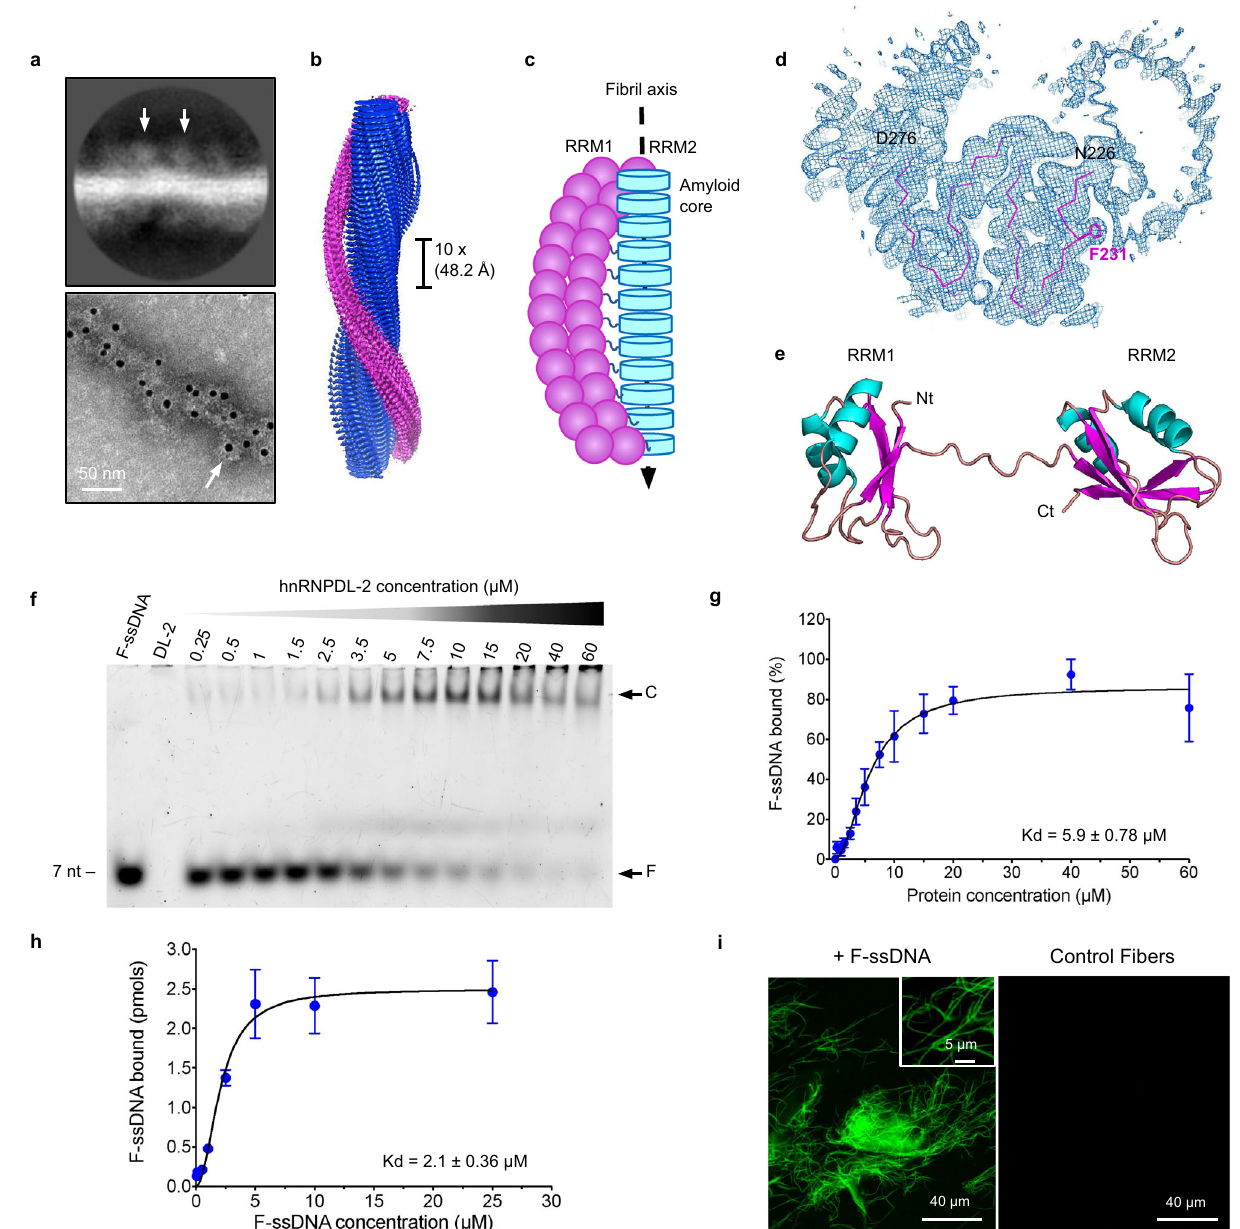
Fig. 4 | Structure oftheRNA/DNA-binding domains fromhnRNPDL-2and their location in the amyloid fi laments. a Top panel, representative 2D class average image showing hnRNPDL-2 fi brils with an approximate solenoid coat of globular domains. The arrows indicate the location of the density assigned to the RRMs. Bottompanel,negative-stainelectronmicroscopy(EM)micrographsofhnRNPDL-2 fi laments bound to nanogold-antibodies (~10nm, white arrow) targeting the loca- tion of the hnRNPDL-2 globular domains. The N-terminal 6xHis tag was labelled using nanogold-conjugated secondary antibodies against anti-6xHis antibodies produced in mouse. Representative image from two independent experiments. Scale bar, 50nm. b 3D unsharpened density map reconstruction of hnRNPDL-2 fi bril. Densities for the amyloid core and putative RRMs are colored in blue and pink, respectively. The 10x fi lament rise/subunit is indicated in Å. c Schematic diagramshowingtheproposedorganizationoftheRRMdomains(pink)aroundthe fi bril core (cyan). d Cross-sectional view of the unsharpened cryo-EM map of hnRNPDL-2 fi bril, with the superimposed hnRNPDL-2 amyloid core in a ribbon representation.ThesidechainofF231isrepresentedassticks. e Modelstructureof